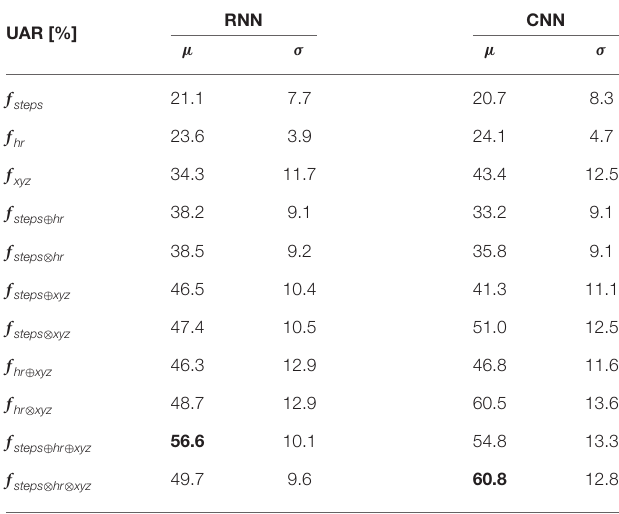
TABLE 4 | Summary of the descriptive statistics ( µ : mean, σ : standard deviation) computed from the UAR scores obtained when assessing the unimodal and